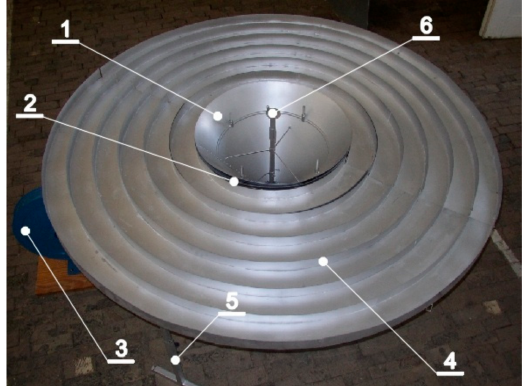
Figure 1. Test stand: 1—inner cone surface, 2—outer cone surface, 3—fan, 4—troughs, 5—base, 6—knob for infinitely variable adjustment of the charging slot.